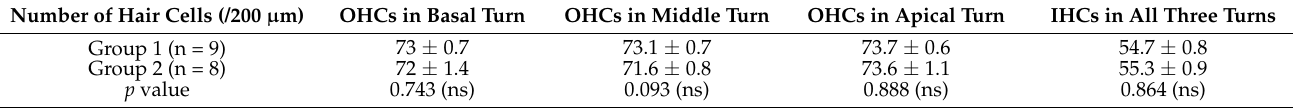
Figure 5. Confocal microscopy of cochlear hair cells. The organ of Corti appeared normal in both groups with minimal hair cell loss (white asterisks) in all three turns of the cochlea. When the number of hair cells was compared, there was no difference between groups 1 and 2. Table 1. The number of hair cells in the basal, middle, and apical turns of the cochlea OHC, outer